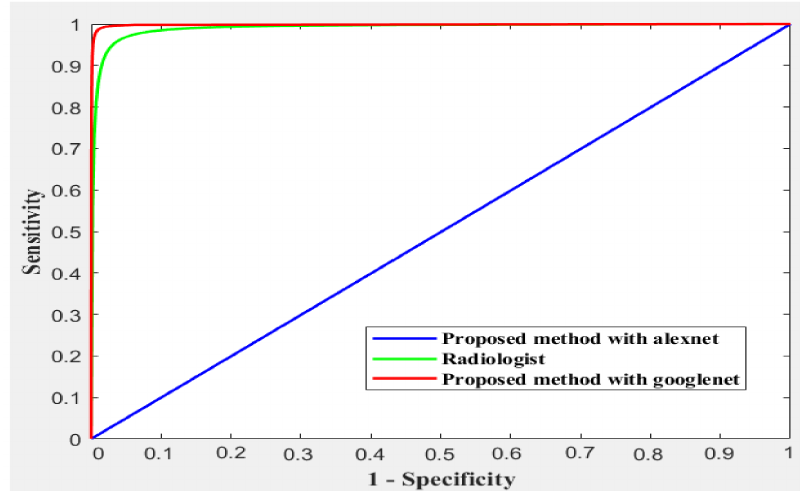
Figure 11. The ROC curves of the compared